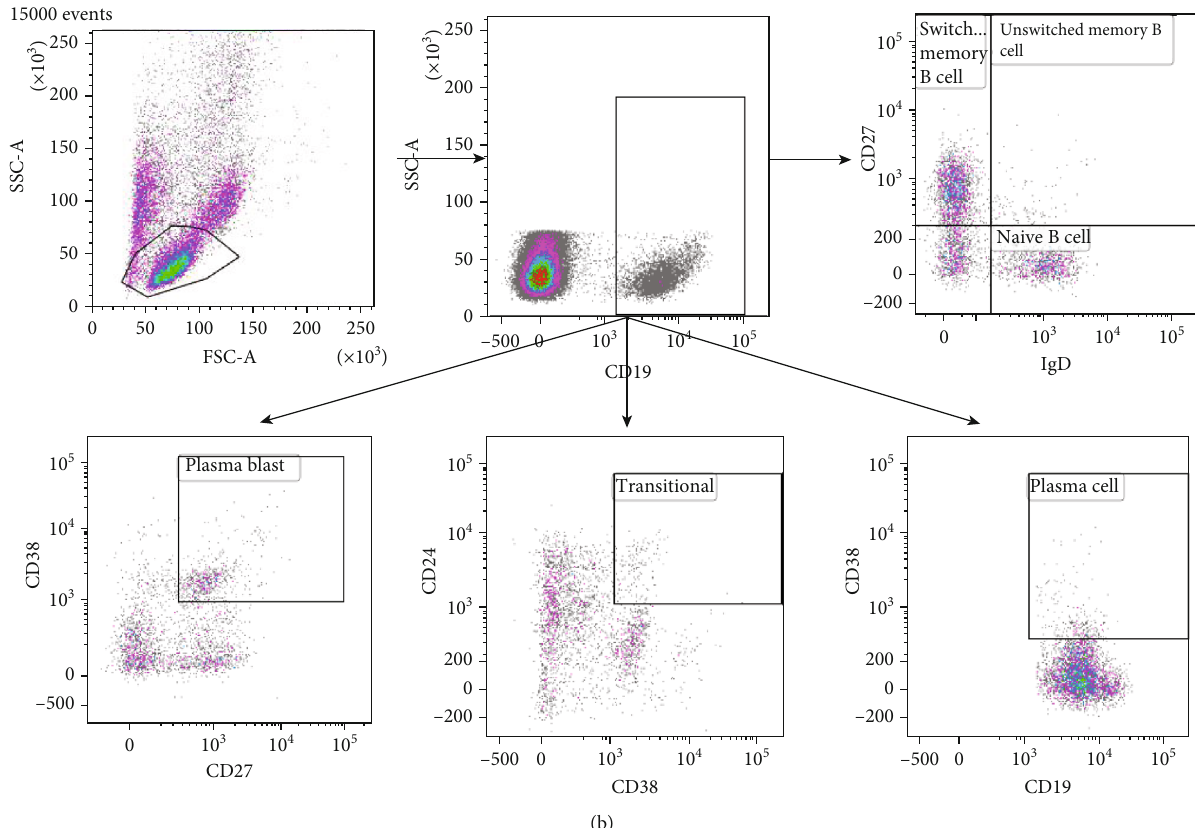
Figure 1: Gating strategy for analysis using logic gates. Measurements were performed with fresh blood samples. (a) Tfh cells were de fi ned as CD4 + CXCR5 + T cells in the lymphocyte population. The Tfh cell phenotypes were PD-1 + ICOS + CD4 + CXCR5 + T cell (PD-1 + ICOS + Tfh cells), CD226 + CD4 + CXCR5 + T cell (CD226 + Tfh cells), and TIGIT + CD4 + CXCR5 + T cell (TIGIT + Tfh cells). (b) B cells were further de fi ned as CD19-expressing cells in the lymphocyte population. CD19 + B cells were analyzed for the expressions of IgD and CD27, CD24, and CD38. The B cell populations included CD27 - IgD + (naïve B cells), CD27 + IgD + (unswitched memory B cells), CD27 + IgD - (switched memory B cells), CD24 ++ CD38 ++ (transitional B cells), CD27 + CD38 + (plasmablasts), and CD38 + B cells (plasma